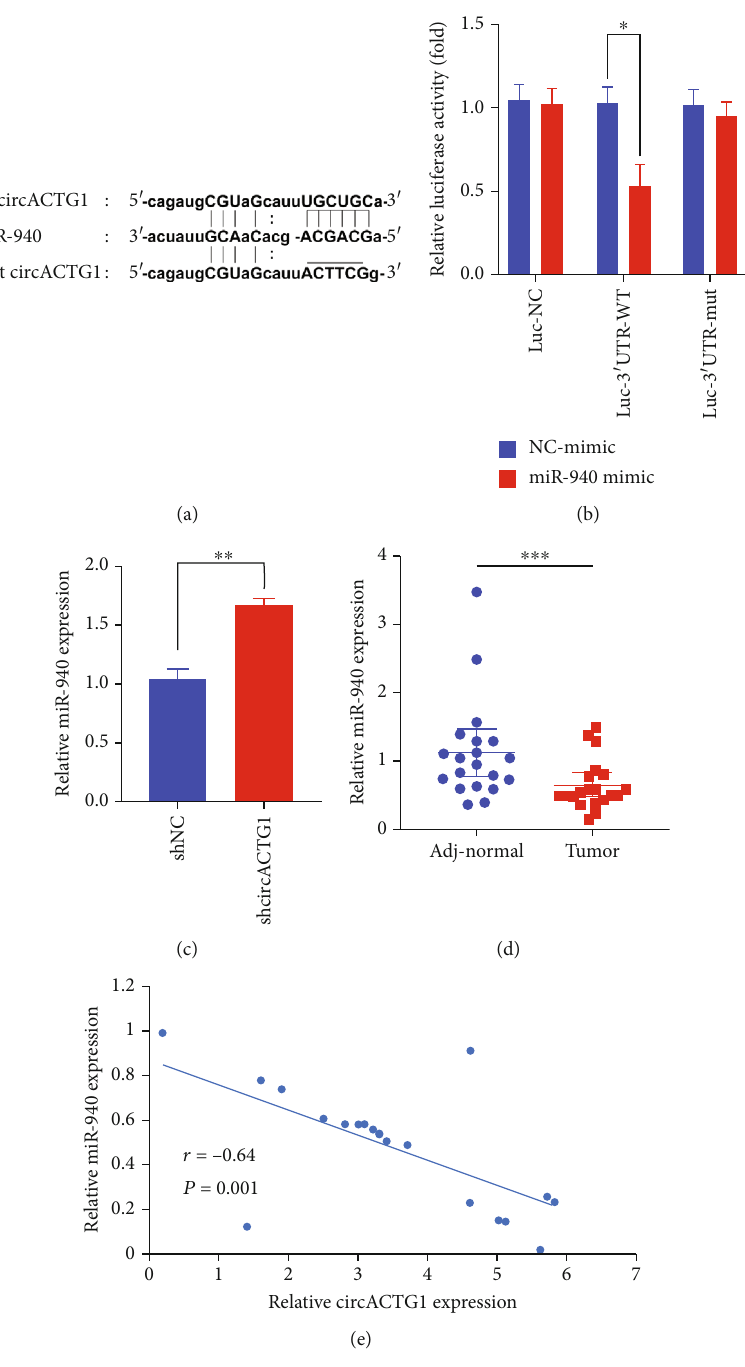
Figure 3: circACTG1 played as a miR-940 sponge in HCC. (a) circACTG1 may act as a miR-940 sponge as demonstrated by bioinformatics analysis predicted by circBase. (b) miR-940 mimic could markedly downregulate the luciferase activity of circACTG1. (c) circACTG1 knockdown signi fi cantly promoted the expression level of miR-940. (d) Expression of miR-940 in adjacent normal and tumor tissues. (e) Correlation of circACTG1 and miR-940 by Spearman ’ s correlation coe ffi cient